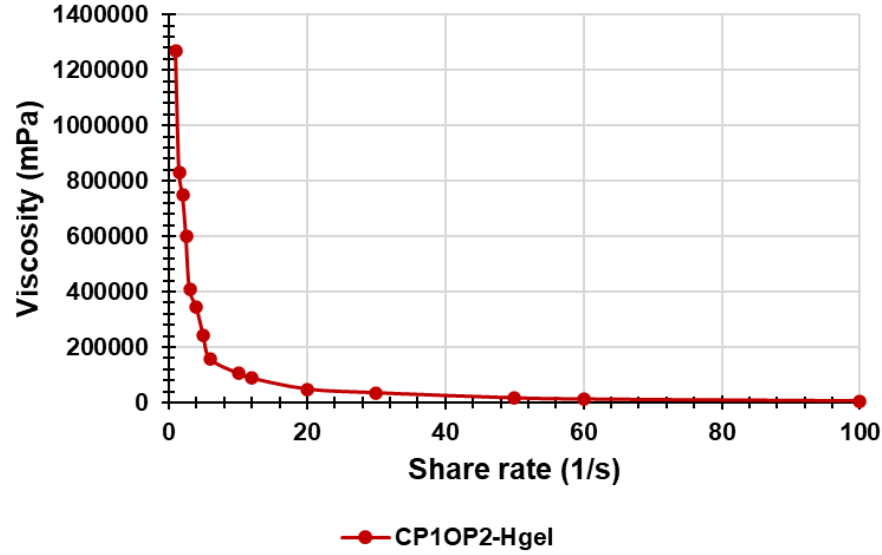
Figure 12. Curve of dynamic viscosity vs. shear rate.